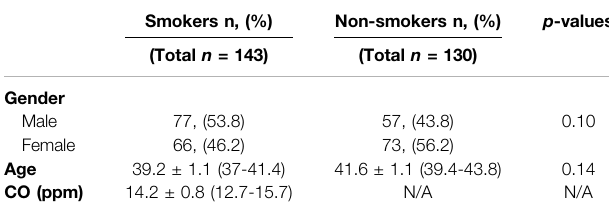
TABLE 2 | Demographics and number of individuals in each group according to smoking